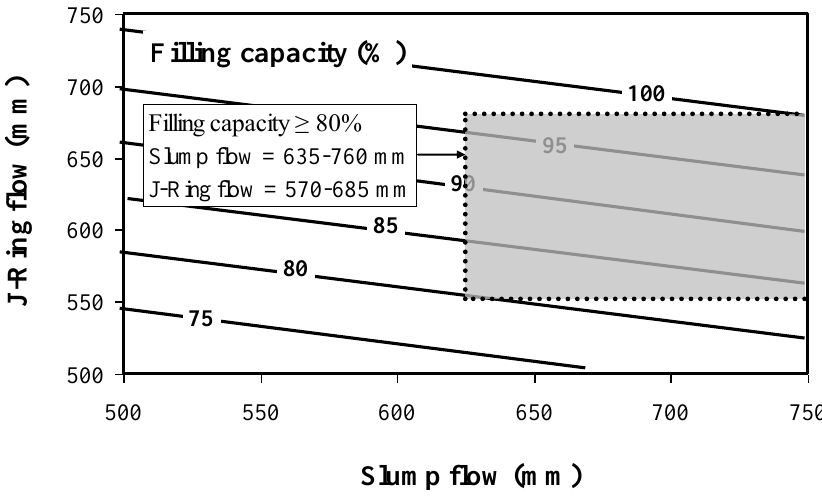
Figure 2. Contour diagrams between filling capacity, slump flow, and J-Ring flow determined at 10 min (R² = 0.83) (Equation (2)).